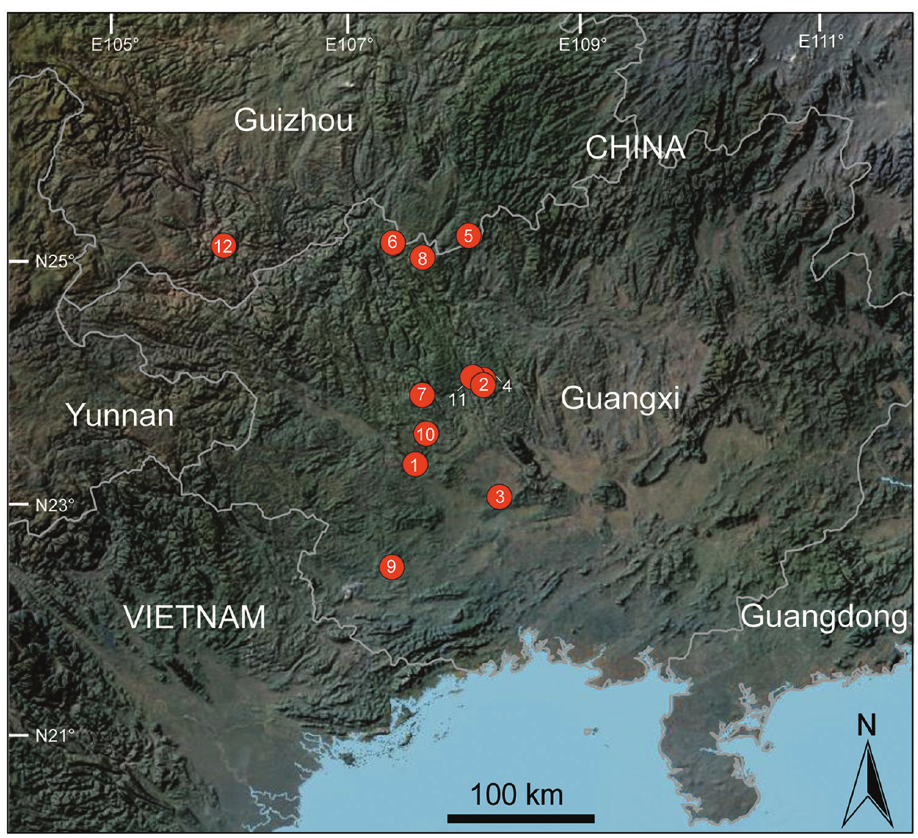
Figure 31. Distribution records of Pinelema bailongensis species group: 1 P. bailongensis 2 P. cheni Zhao et Li, sp. n. 3 P. cordata 4 P. huoyan Zhao & Li, sp. n. 5 P. liangxi 6 P. lizhuang Zhao & Li, sp. n. 7 P. stren- tarsi 8 P. wangshang Zhao & Li, sp. n. 9 P. wenyang Zhao & Li, sp. n. 10 P. xiushuiensis 11 P. yunchuni Zhao & Li, sp. n. 12 P. zhewang